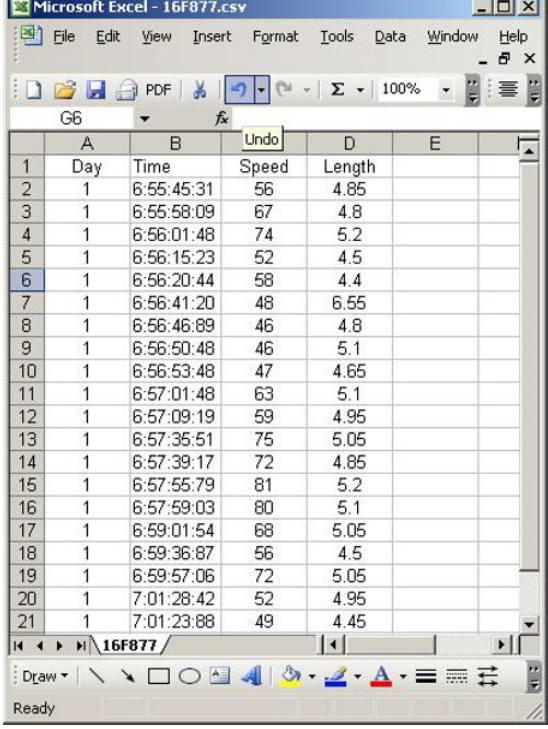
Figure 10. CSV file